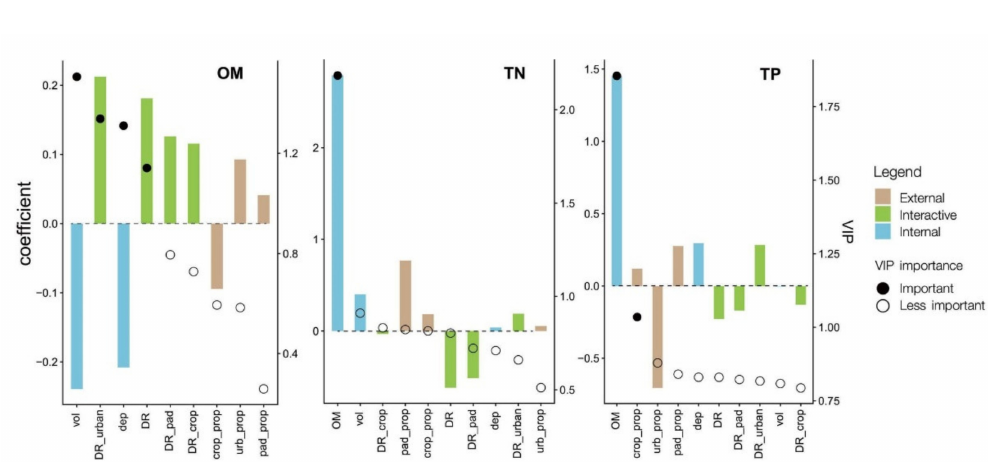
Figure 5. Partial least squares regression (PLS) output for the change rate (%) of organic matter (OM), total nitrogen (TN), and total phosphorus (TP). Variables are listed with regression coefficients in descending VIP (variable importance to the projection) index order. VIP > 1 is considered important (filled circles) and VIP < 1 is less important (open circles). For abbreviations, see Figure